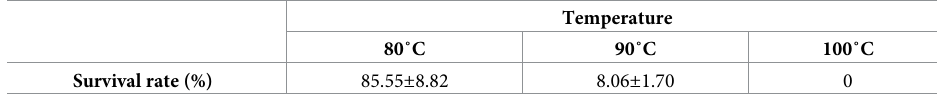
Table 4. Survival rate of C . sartagoforme XN-T4 at different temperatures after 10 min.